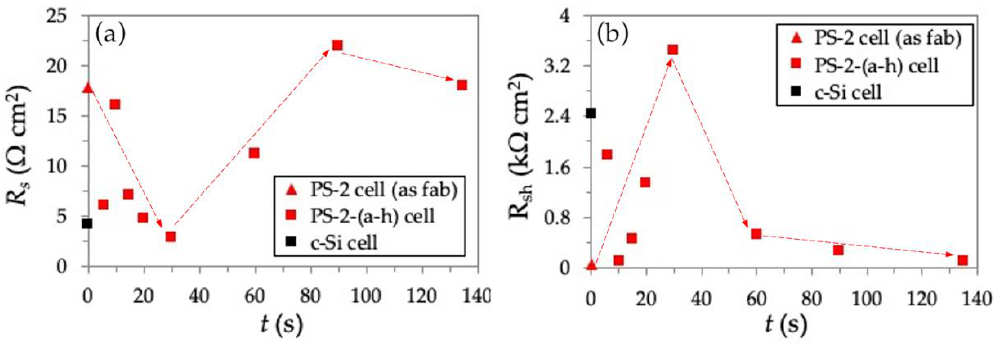
Figure 8. Correlation between t and ( a ) R s ; ( b ) R sh for as-fabricated PS-2 cell, passivated PS-2(a-h) cells, and reference c -Si cell.